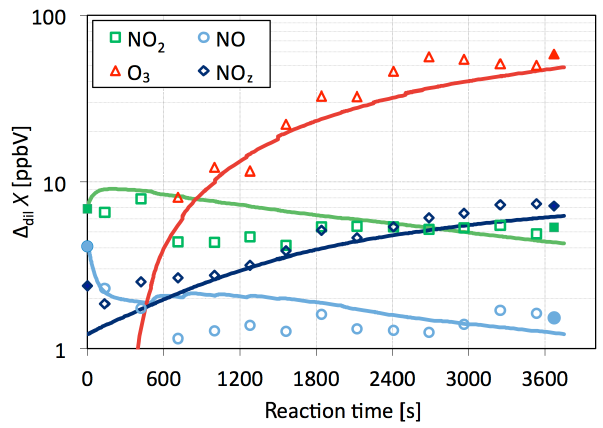
Figure 7. Dilution-corrected molar excess mixing ratios of PAN during 1h of plume evolution (in 1km bins). Point symbols refer to the measured data; the solid line represents the output of the UWCM based on MCM v3.3